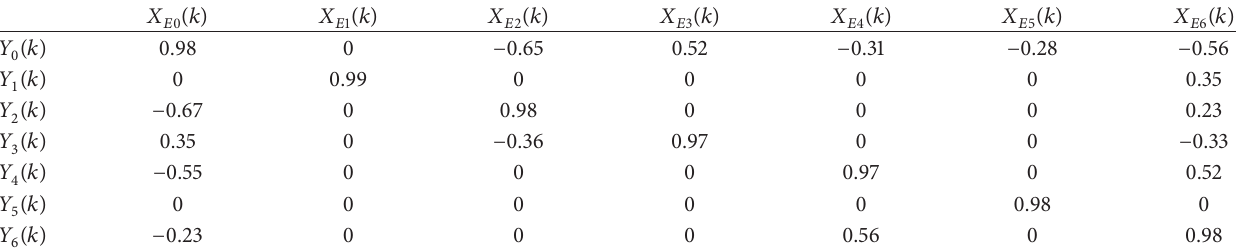
of the sensitivity of emotional YF